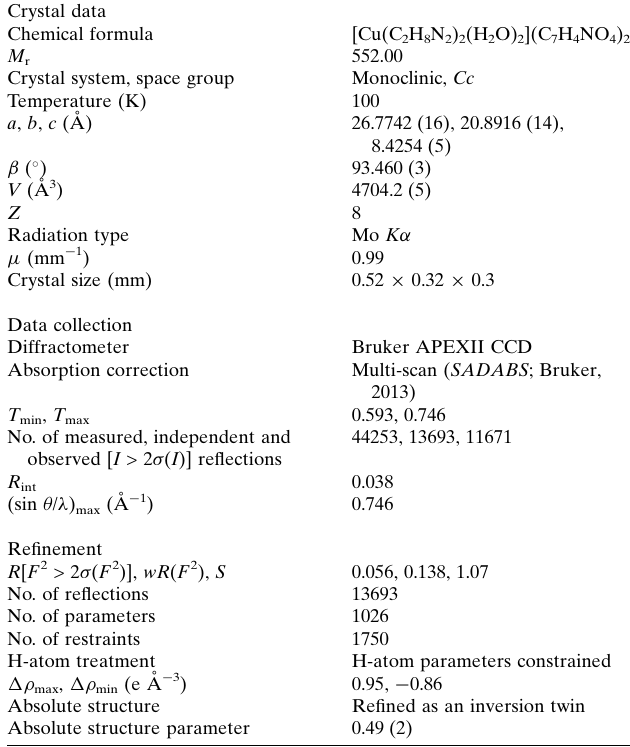
Crystal data Chemical